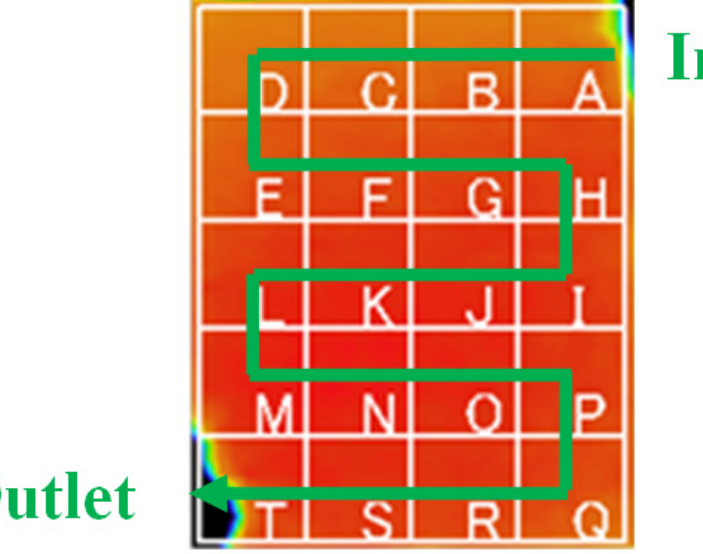
Figure 3. Segment of the temperature range. The 20 segment areas were named from A to T, along with the gas flow through the gas channel.